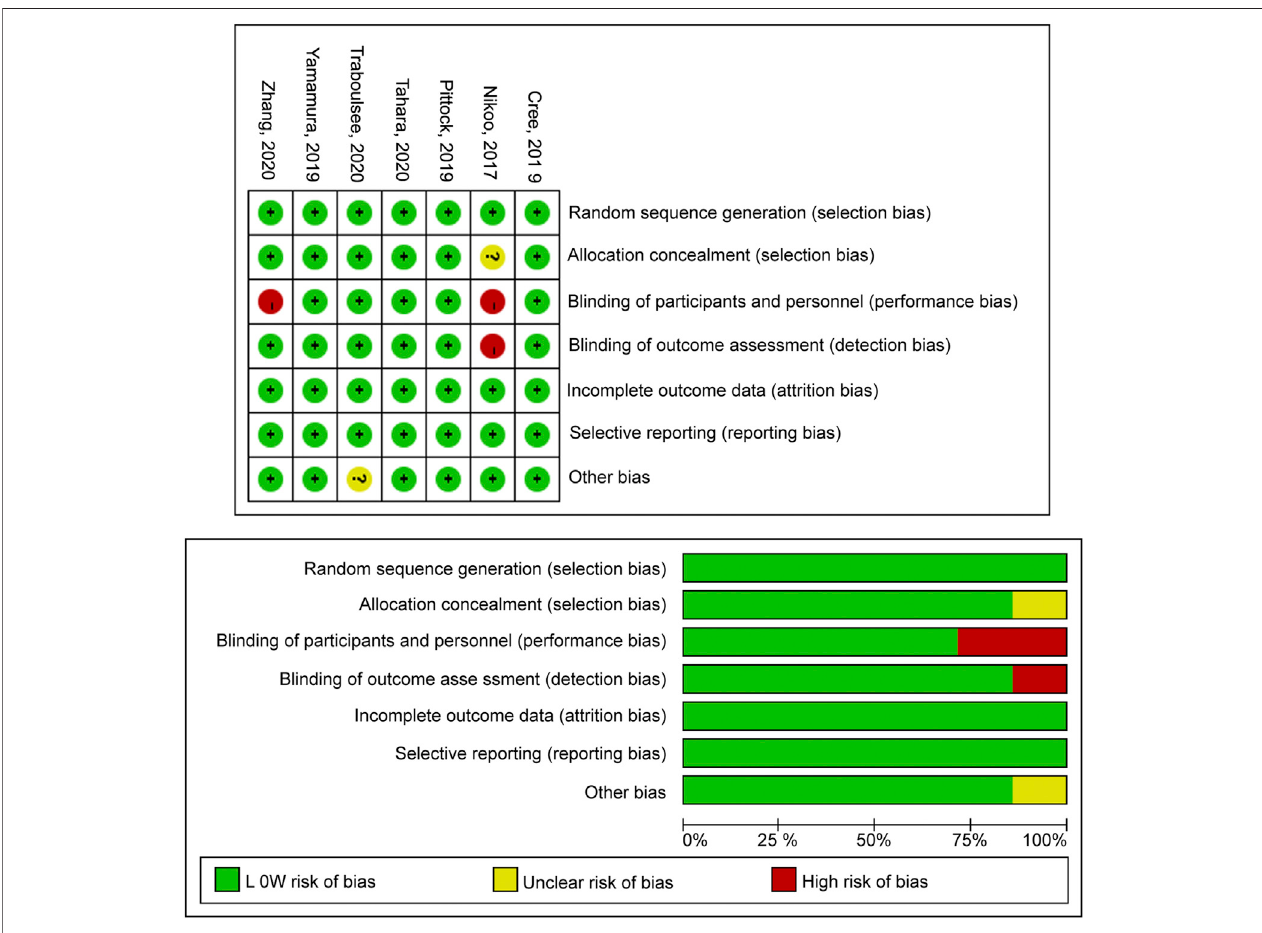
FIGURE 7 | Cochrane criteria for quality of